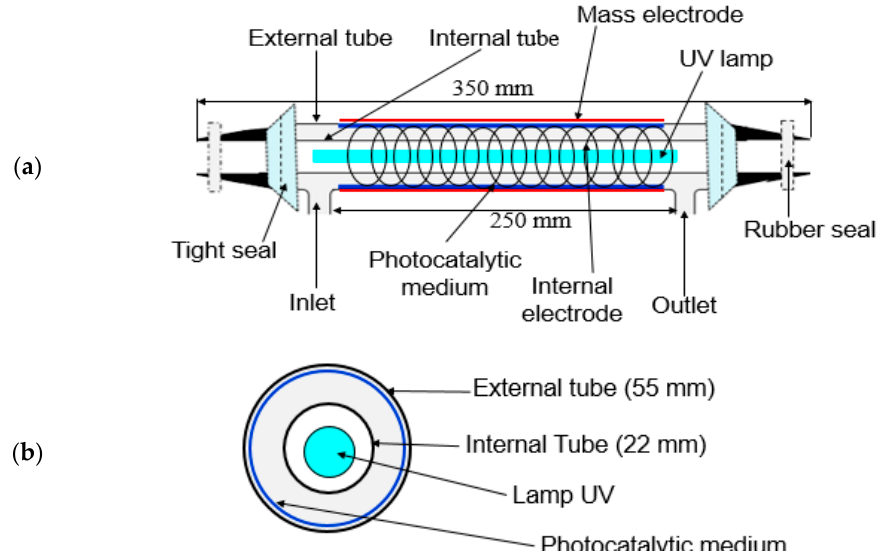
Figure 7. ( a ) Schematic of the reactor setup and ( b ) cross-section of the concentric cylindrical Pyrex glass tube reactor.